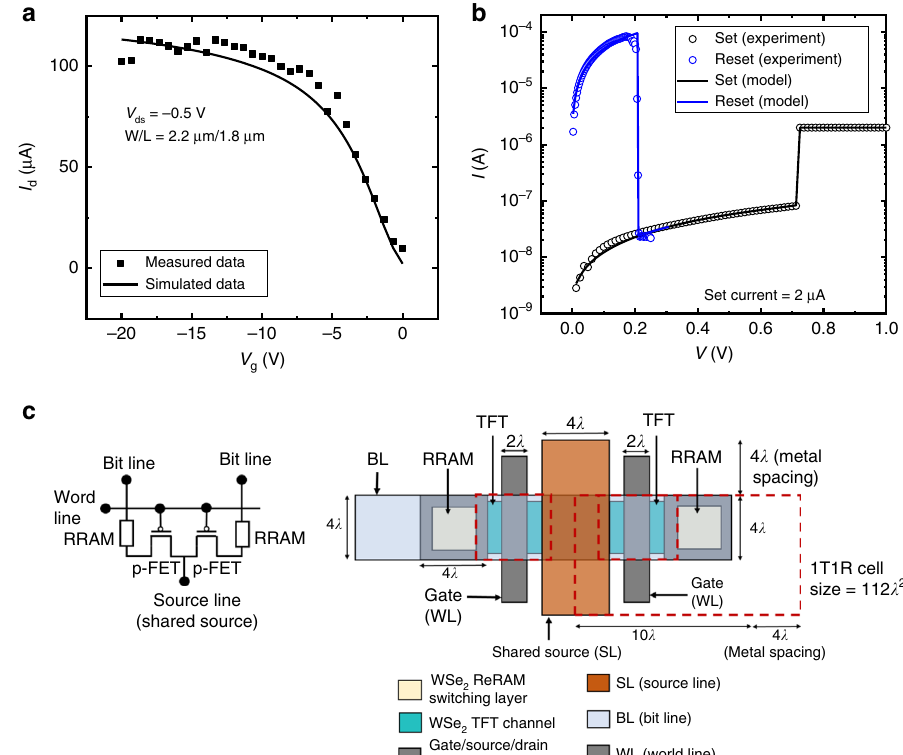
Fig. 5 Compact modeling and circuit simulations. a I d – V g of SPICE TFT model vs. measured WSe 2 p -FET. b I – V of SPICE ReRAM model vs. measured for SET and RESET process. c Circuit representation and layout of shared SL 1T1R structure, with the 1T1R cell size indicated (BL — bit line; WL — word line; SL — shared-source